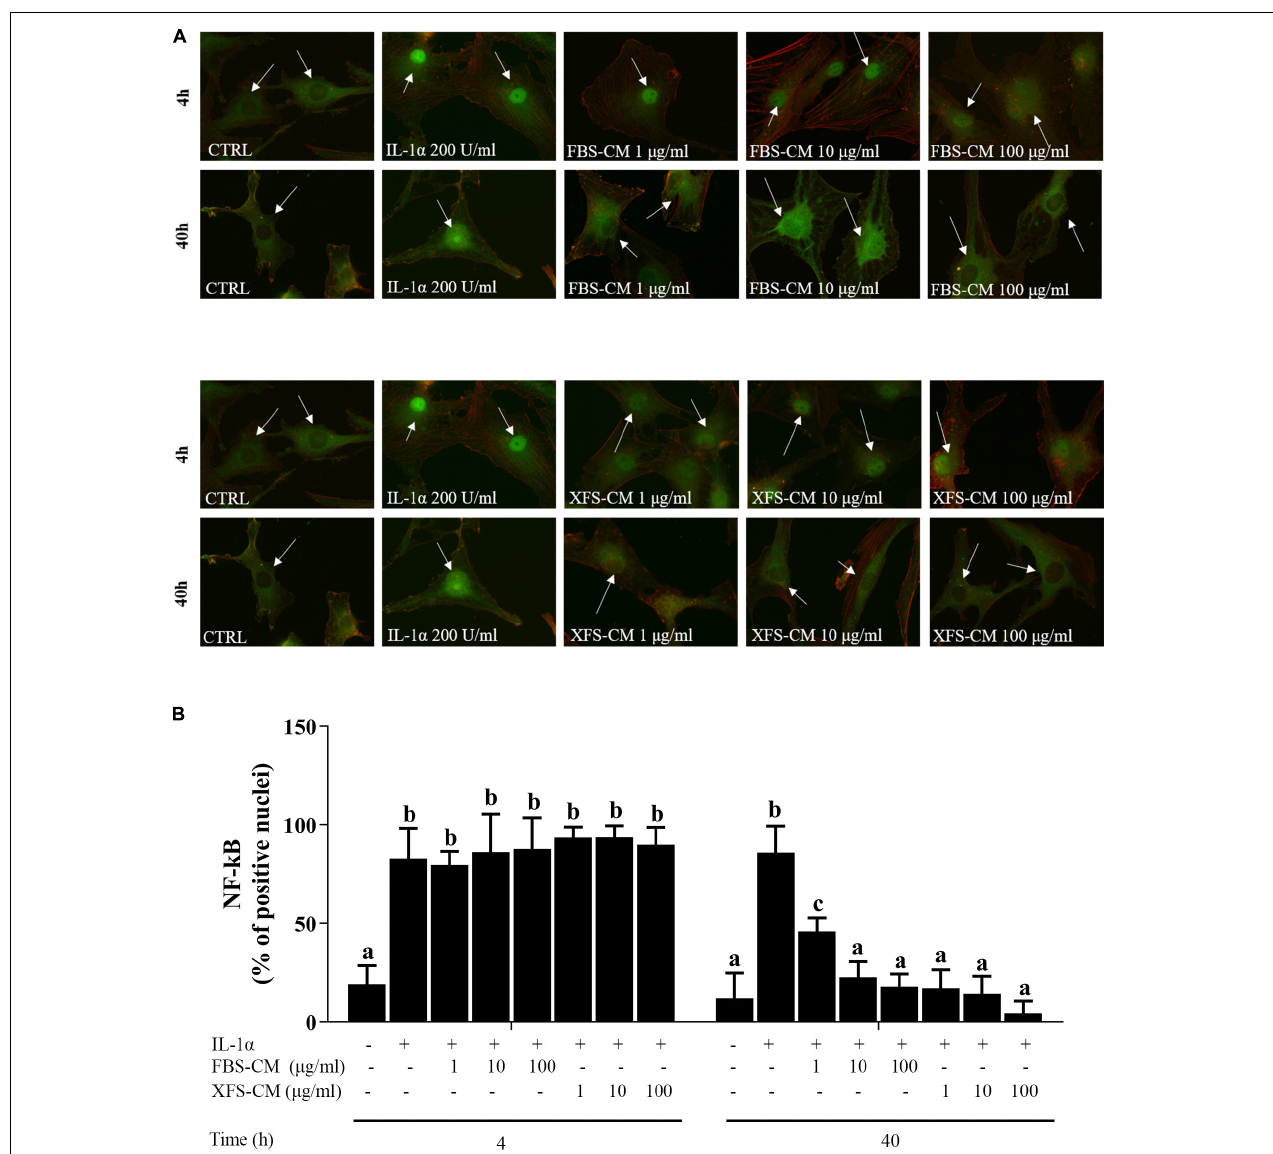
FIGURE 4 | NF-kB nuclear translocation in OA hACs in response to CM treatment. hACs from at least six donors were treated with hBMSC-CM from two allogeneic hBMSC donors and with or without 200 U/ml IL-1 α for 4 and 40 h. (A) hBMSC-CM inhibited IL-1 α -induced nuclear translocation of NF-kB, as showed by immunofluorescence analysis. White arrows show the nucleus of the cells. Representative images of six independent experiments are shown. (B) Quantification of the data presented in A. Data are shown as mean ± SD. Values with shared letters are not significantly different ( P > 0.05) according with two-way ANOVA followed by Tukey as post hoc